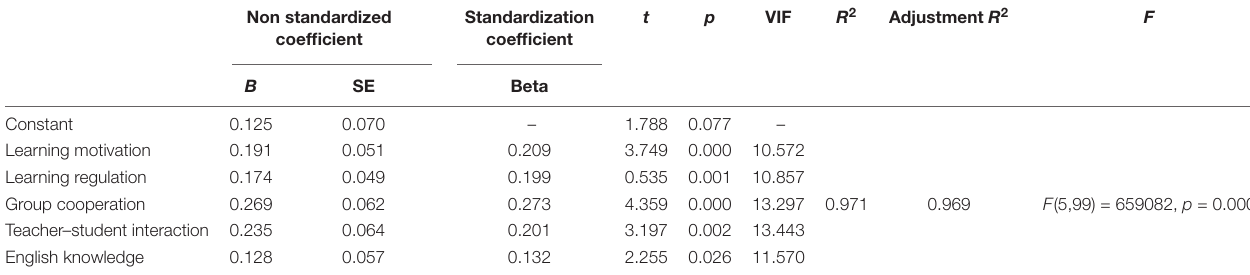
TABLE 1 | Stepwise regression results of factors influencing behavioral input of non-English majors.